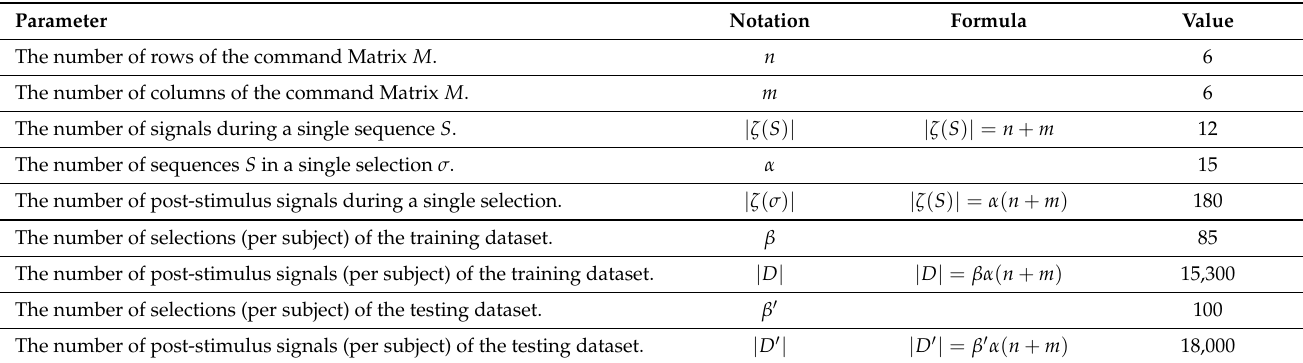
Table 2. Description of the benchmarking dataset.